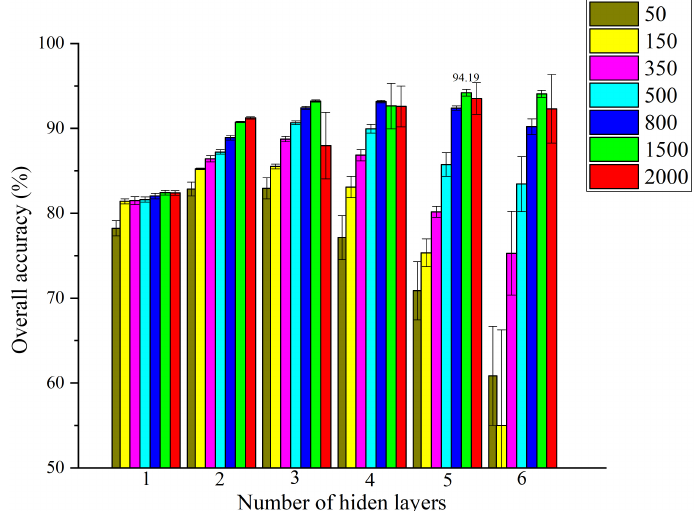
Figure 8. The average and standard deviation values of overall accuracy for validate set derived from different parameter